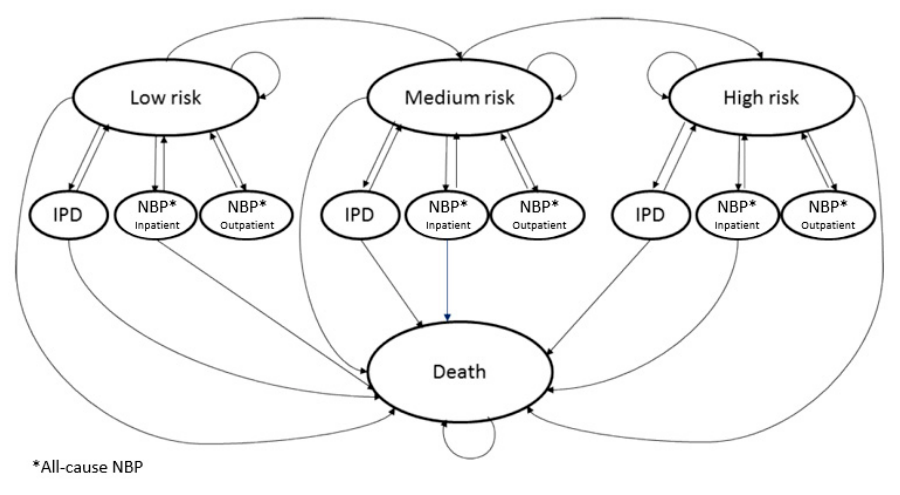
Figure 1. Model structure. Note: IPD: invasive pneumococcal disease; NBP: all-cause nonbacteremic pneumonia.